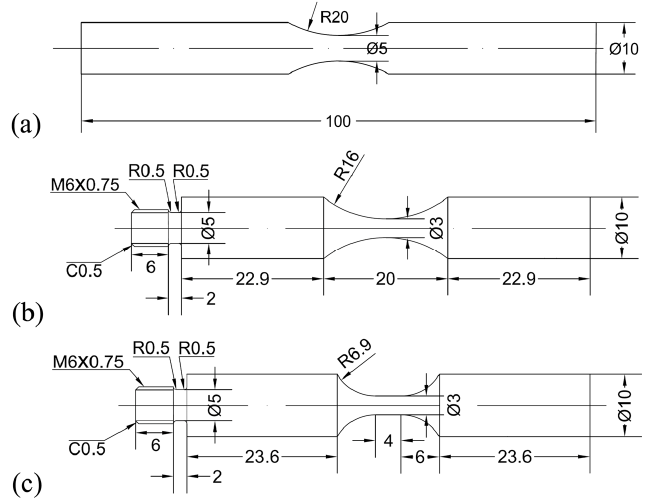
Figure 3. Shape and dimensions (in mm) of specimens for fatigue test. ( a ) Hourglass specimen for